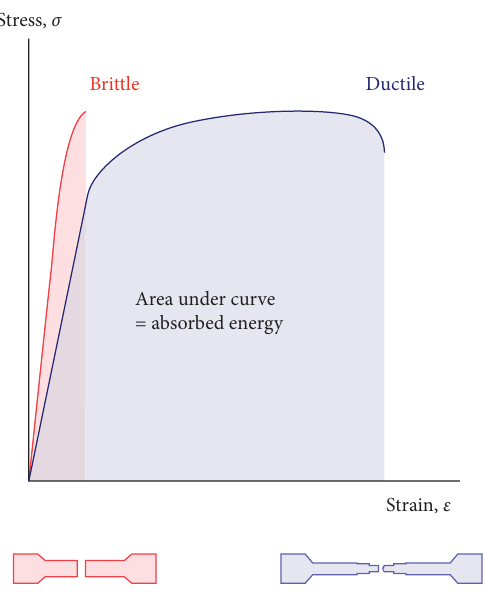
Figure 4: The behavior of fragile and ductile materials